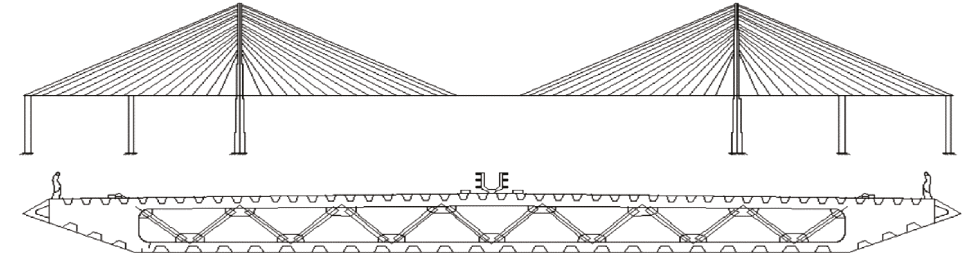
Figure 1: Schematic diagram of long-span